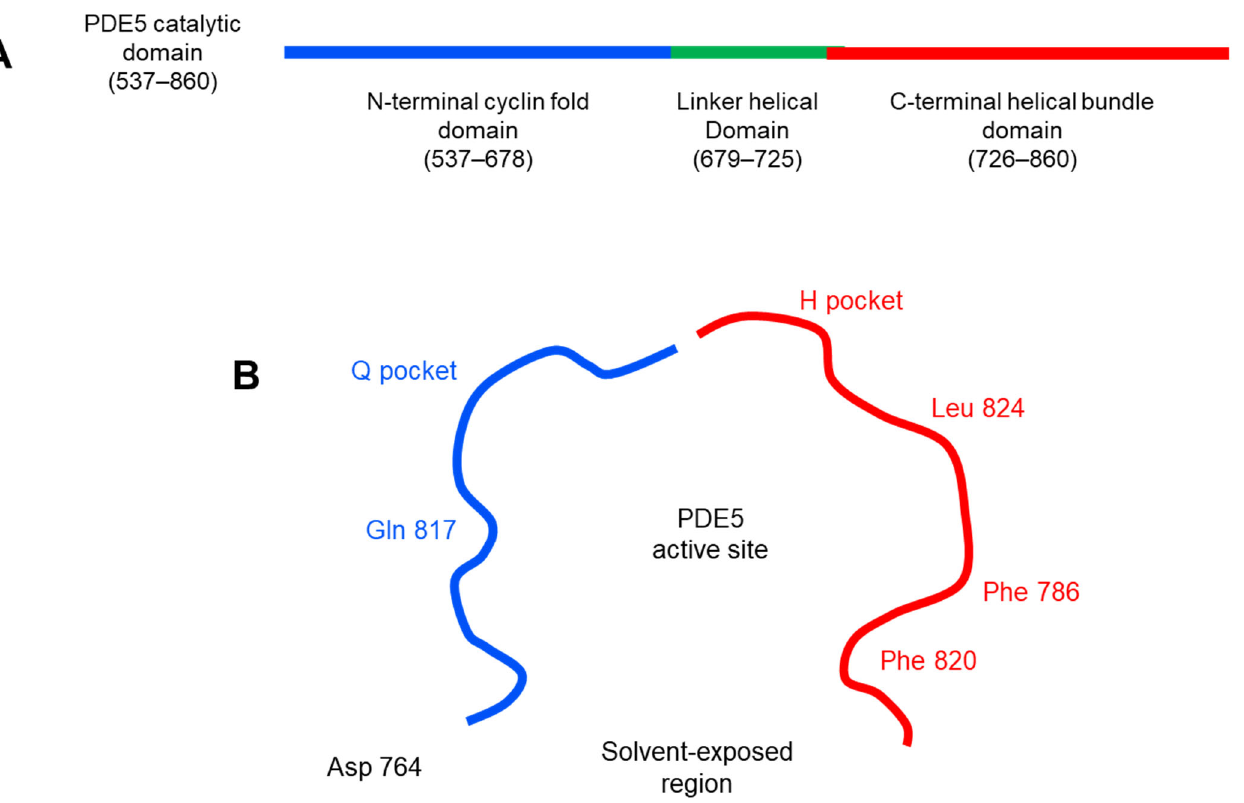
Figure 6. 2D diagram of PDE5 active site (PDB ID: 3HC8). ( A ) the catalytic domain of PDE5 enzyme can be divided into three subdomains: N ‐ terminal cyclin ‐ fold domain (residues 537–678 in blue), linker helical domain (residues 679–725 in green) and C ‐ terminal helical bundle domain (residues 726–860 in red). ( B ) the active site of PDE5 can be described in 3 core regions: H pocket (hydrophobic pocket) in red color with key hydrophobic amino acid residues (Phe 786, Phe 820 and Leu 824), Q pocket (cGMP binding site) in blue color with Gln 817 as the key amino acid residue in that site and solvent ‐ exposed region with Asp 764.